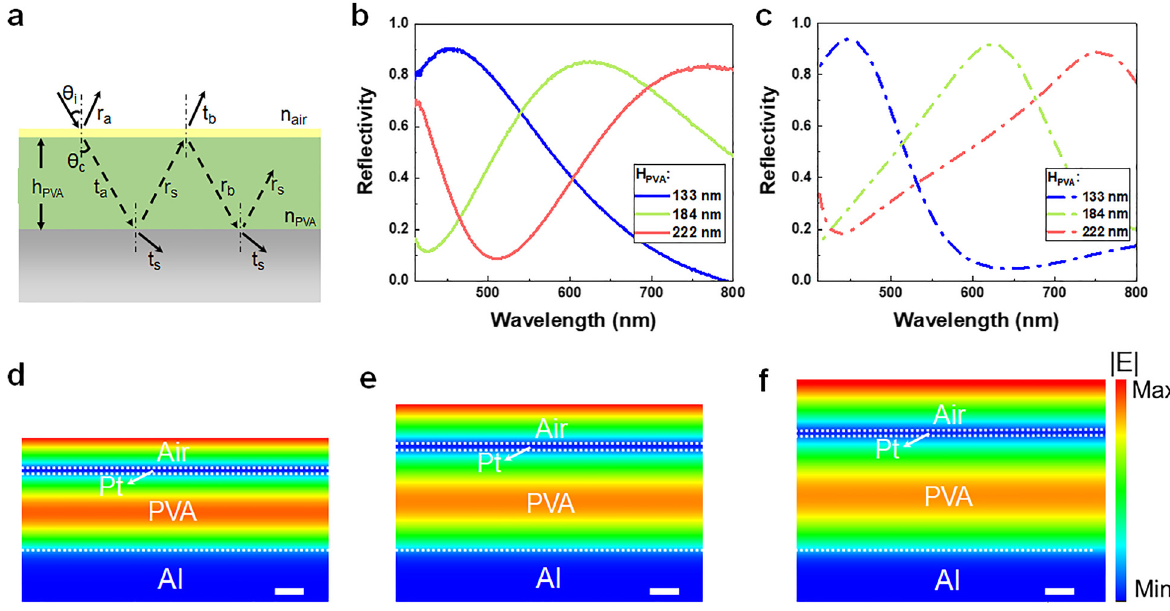
Figure3: (a)Schematicofthemulti-layerinterference,inwhichthereflectionandtransmissioncoefficientswithinmulti-layersareillustrated. (b)Measuredreflectionspectraof thestructurewith H Pt = 14nm, and H PVA =133, 184,222nm, respectively.(c) Simulatedre fl ectionspectraof thestructurewith H Pt =14nm,and H PVA =133,184,222nm,respectively.Electric fi elddistributionsoftheverticalcross-sectionofthestructure at the re fl ective resonances of (d) 448, (e) 623, (f) 753 nm with the hydrogel thicknesses of 133, 184, 222 nm, respectively. The scale bar in (d) – (f) is 50